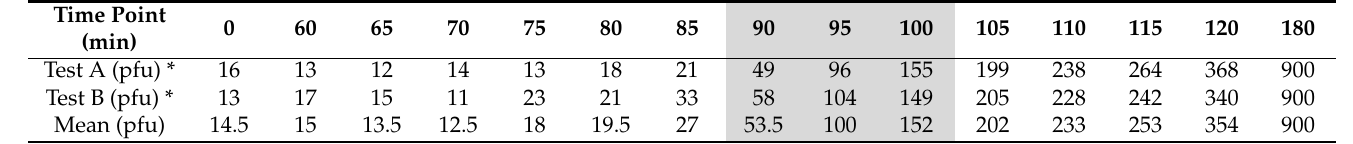
Table 1. Determination of the vB_YenS_P400* burst size and latent period on Y. enterocolitica B4/O:3 strain DSM